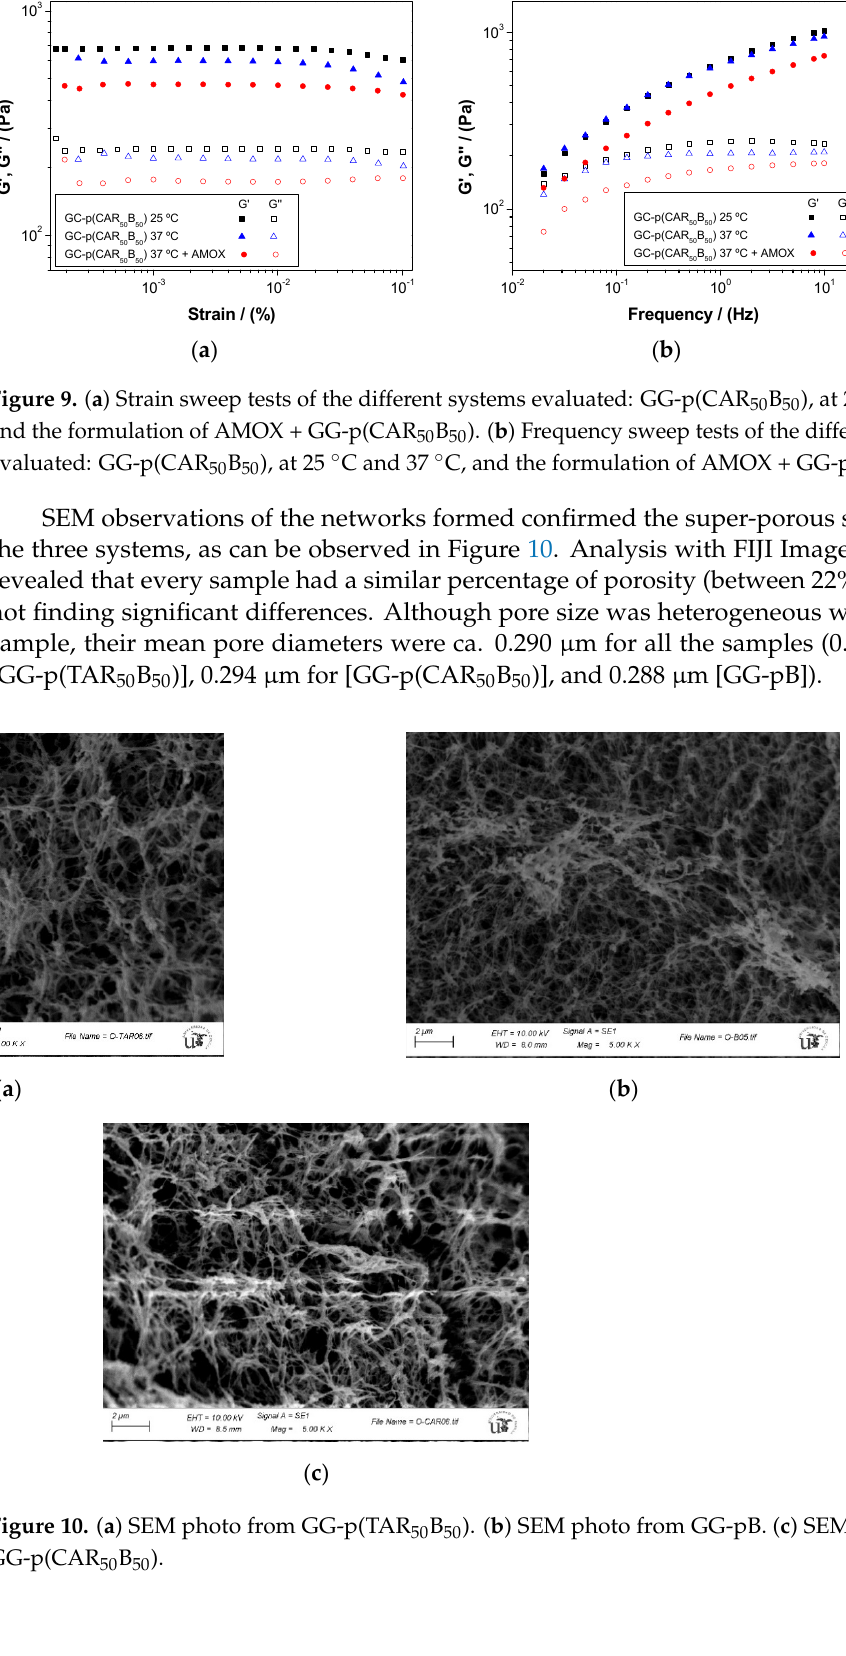
(SGF ‐ 1.2) and pH 5.0 (SGF ‐ 5) at 37 °C. The drug release was determined by UV spectros ‐